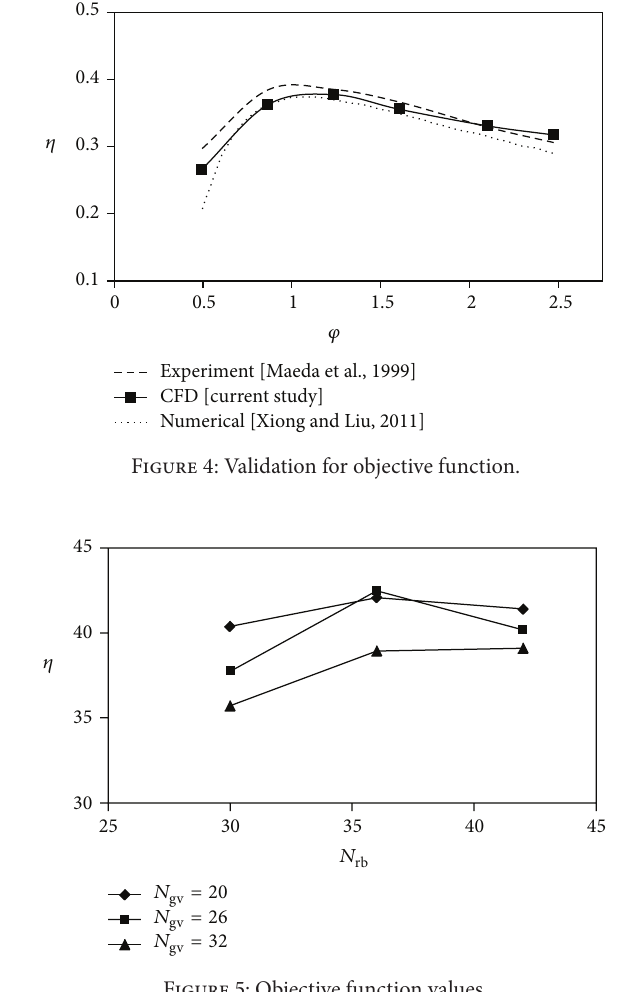
Figure 5: Objective function